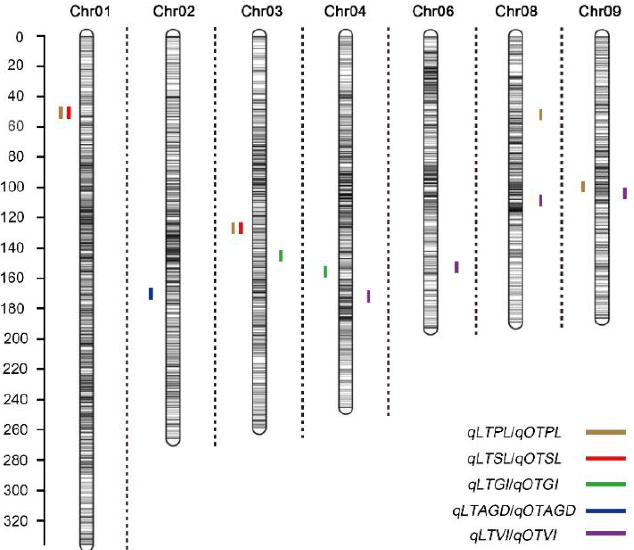
Figure 4. Chromosomal location of quantitative trait loci (QTL) for germination ability under low tem- perature (present in each chromosome left) and optimum temperature (present in each chromosome left) conditions in IBM Syn10 population. LTPL, LTSL, LTRL, LTGR, LTGI, LTVI, LTSVI, and LTAGD represent plumule length at low temperature, seedling length at low temperature, root length at low temperature, germination rate at low temperature, germination index at low temperature, vigor index at low temperature, simple vigor index at low temperature, and average germination days at low temperature, respectively; OTPL, OTSL, OTRL, OTGR, OTGI, OTVI, OTSVI, and OTAGD represent plumule length at optimum temperature, seedling length at optimum temperature, root length at optimum temperature, germination rate at optimum temperature, germination index at optimum temperature, vigor index at optimum temperature, simple vigor index at optimum temperature, and average germination days at optimum temperature, respectively.